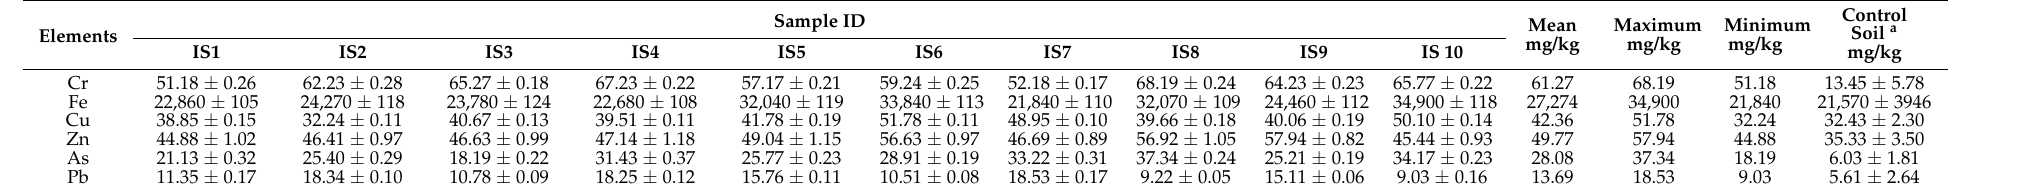
Table 3. Heavy metal concentration (mg/kg) data for industrially affected soil (n = 3) and control soil (n =